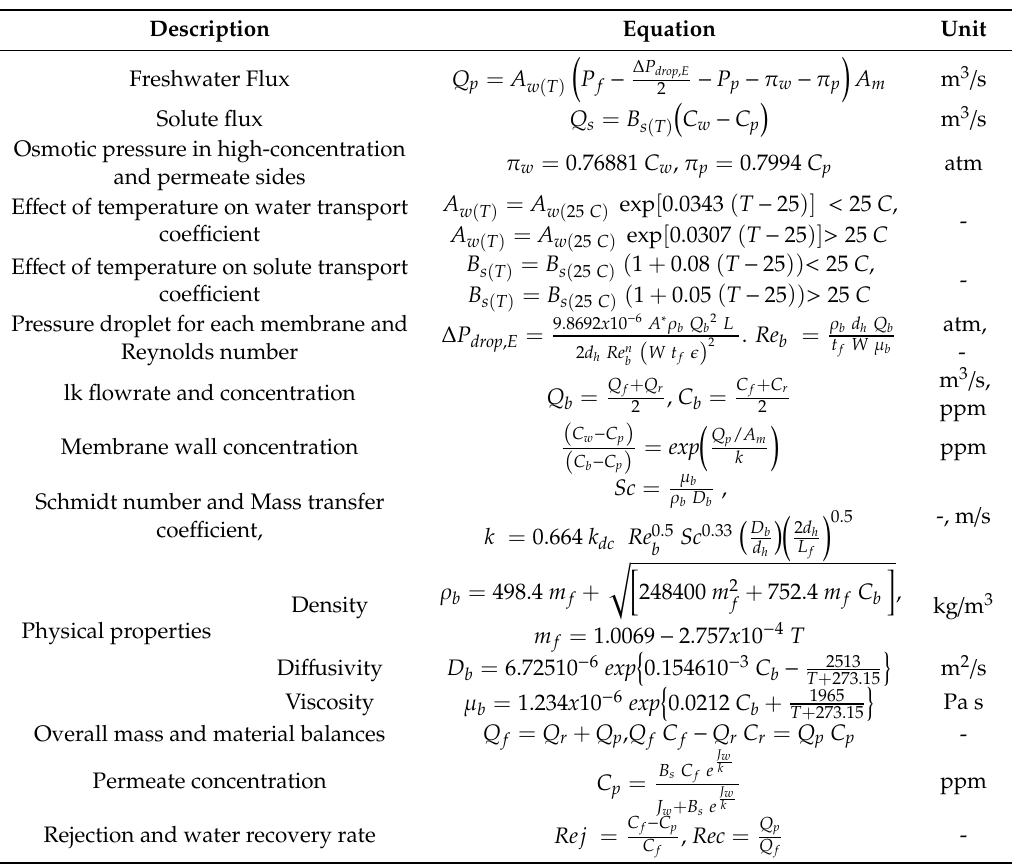
Table A2. Mathematical model of a single reverse osmosis process [7].